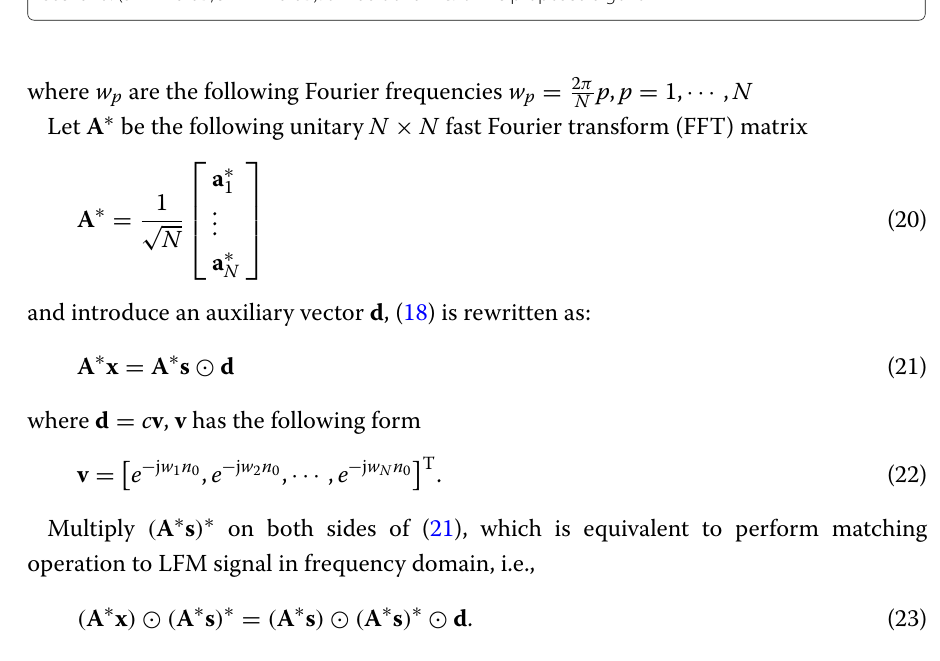
Fig. 4 Contrast between the traditional PC and the proposed algorithm to suppress jamming in the DFTJ scenario. (SNR = 5 dB, JNR = 15 dB). a Traditional PC. b The proposed